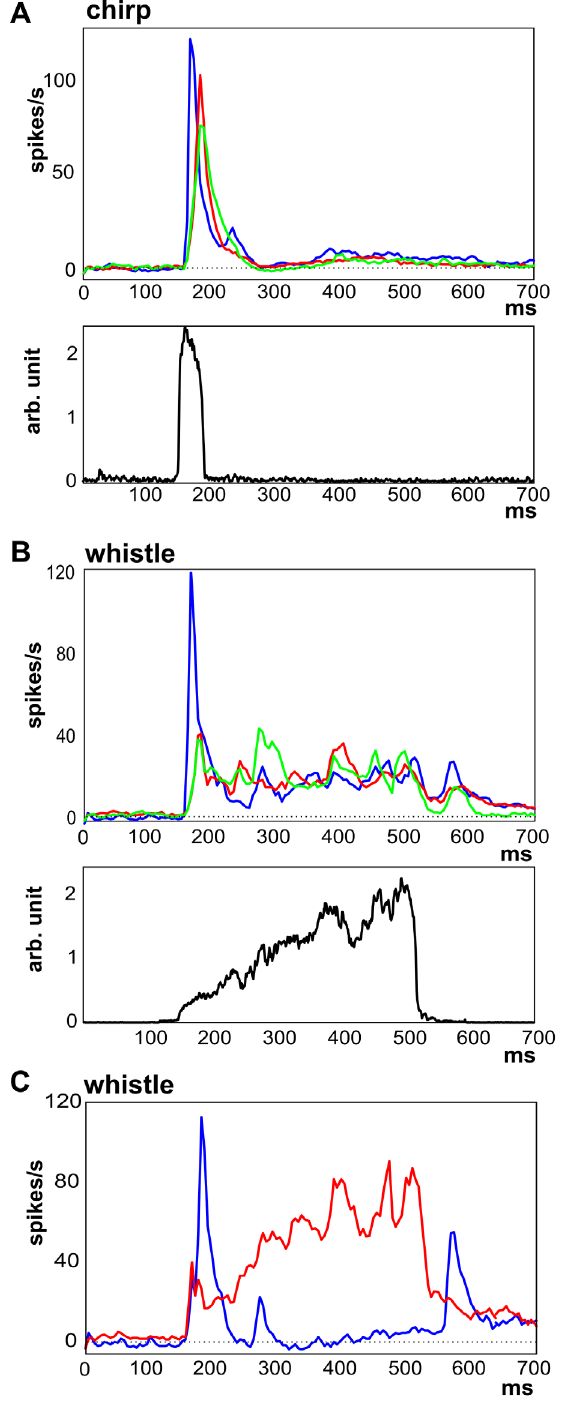
Figure 6. Differences in neuronal response patterns. The subpopulation PSTHs calculated for all low-CF neurons (CF , 7 kHz, blue), middle-CF (7–14 kHz, green) and high-CF ( . 14 kHz, red) subpopulation PSTHs are compared for chirp (A) and whistle (B). The lower panels of (A) and (B) shows the call envelopes. Plot (C) shows a comparison of the subpopulation PSTHs calculated from individual PSTH with negative correlation to sound envelope (blue) and subpopulation PSTHs calculated from individual PSTH with high correlation to sound envelope (r . 0.5, red) for whistle.